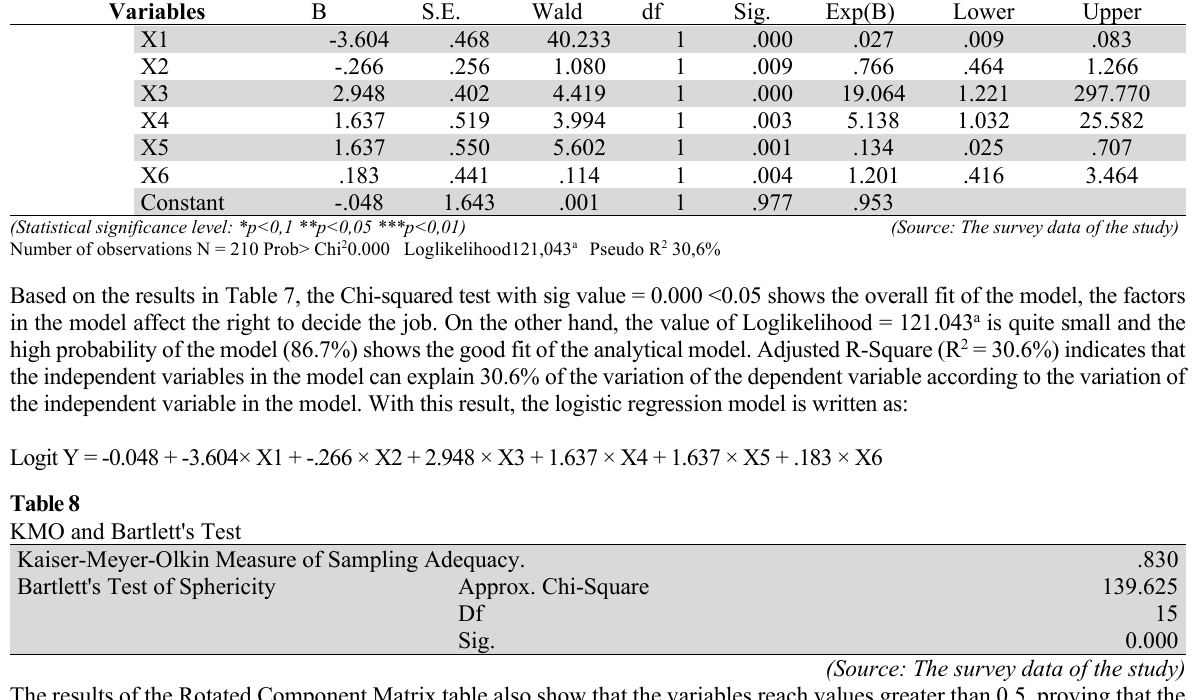
Results for a binary logistic regression model Variables